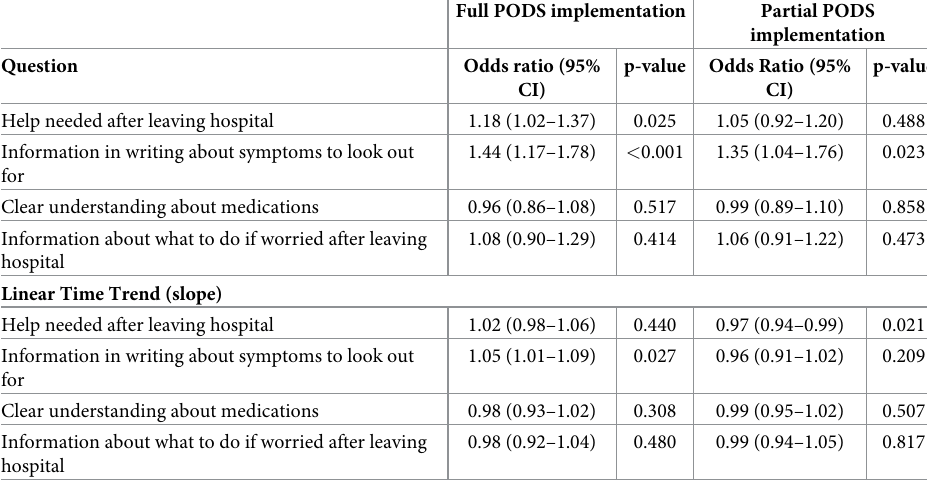
Table 3. Odds of a positive patient experience following discharge from acute care hospital one year following PODS implementation when compared to hospitals with no intervention. Full PODS implementation Partial PODS